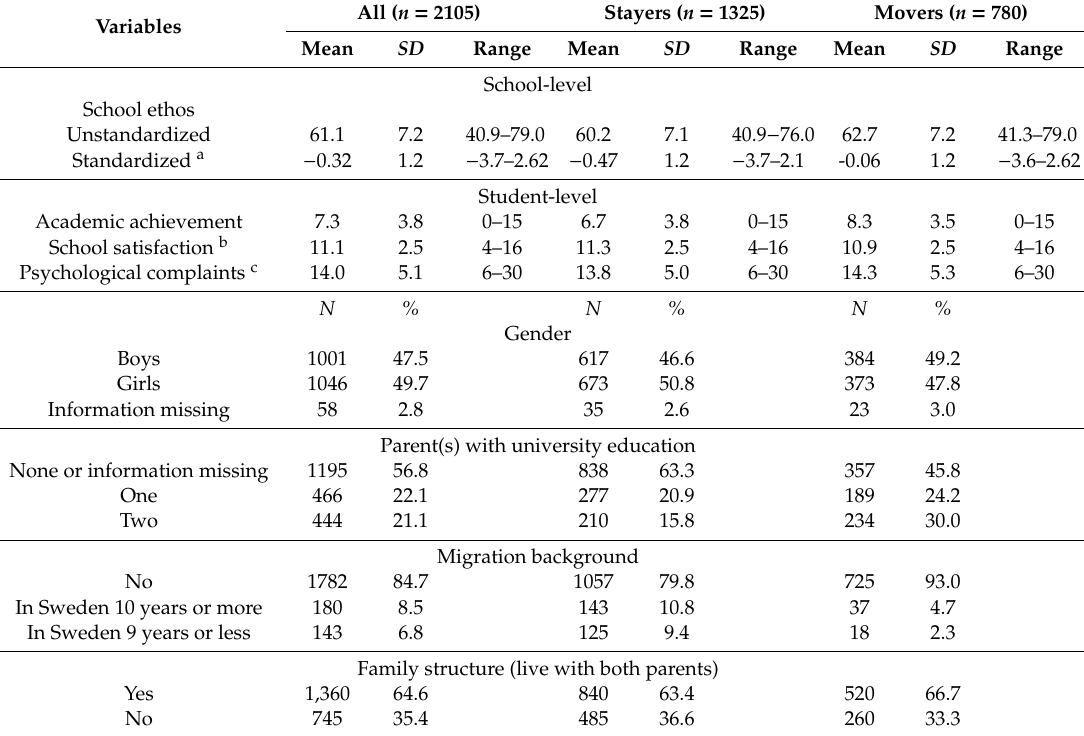
Table 1. Distribution of school- and student-level variables for the study sample and by school choice group, (based on 2105 ninth-grade students distributed across 120 school units in five district areas in Stockholm municipality in 2014 and